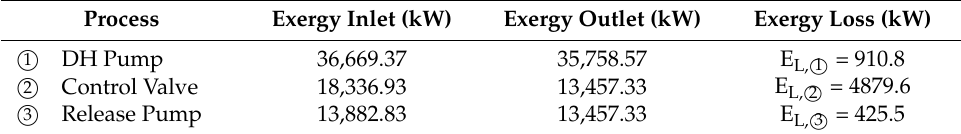
Table 6. Estimation of exergy index for each process of the TES